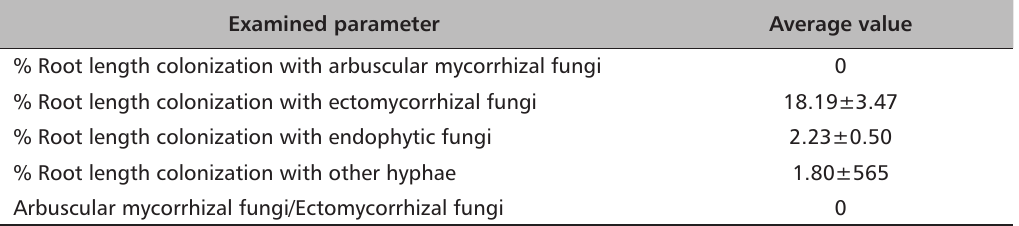
TABLE 5. Average values (±standard error) of poplar roots colonization with ectomycorrhizal, arbuscular mycorrhizal and dark septated endophytic fungi at Timok